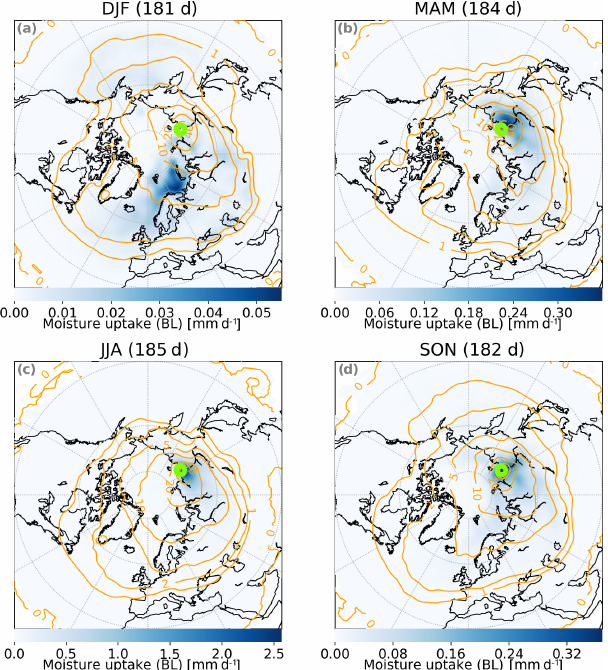
Figure 6. Seasonal averages of boundary layer moisture uptake (mmd − 1 ) for the period 1 July 2015 to 1 July 2017 (North Pole Lambert azimuthal projection) for (a) winter, (b) spring, (c) summer and (d) autumn. The orange contour lines indicate the trajectory lo- cations (as percentage of maximum value: 80%, 40%, 20%, 10%, 5%, 2%, 1% and 0%). The green circles indicate the location of the Samoylov